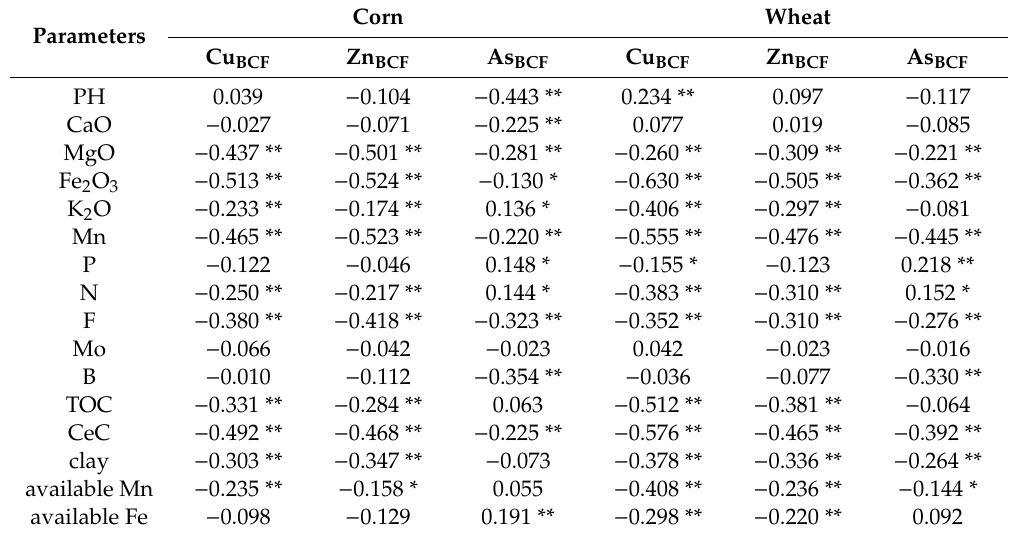
Table 4. The relationship between BCF of crop and soil